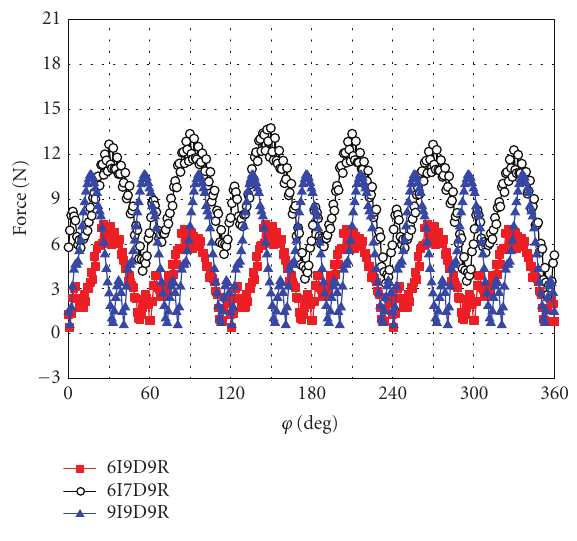
Figure 16: Total force on a single di ff user vane.